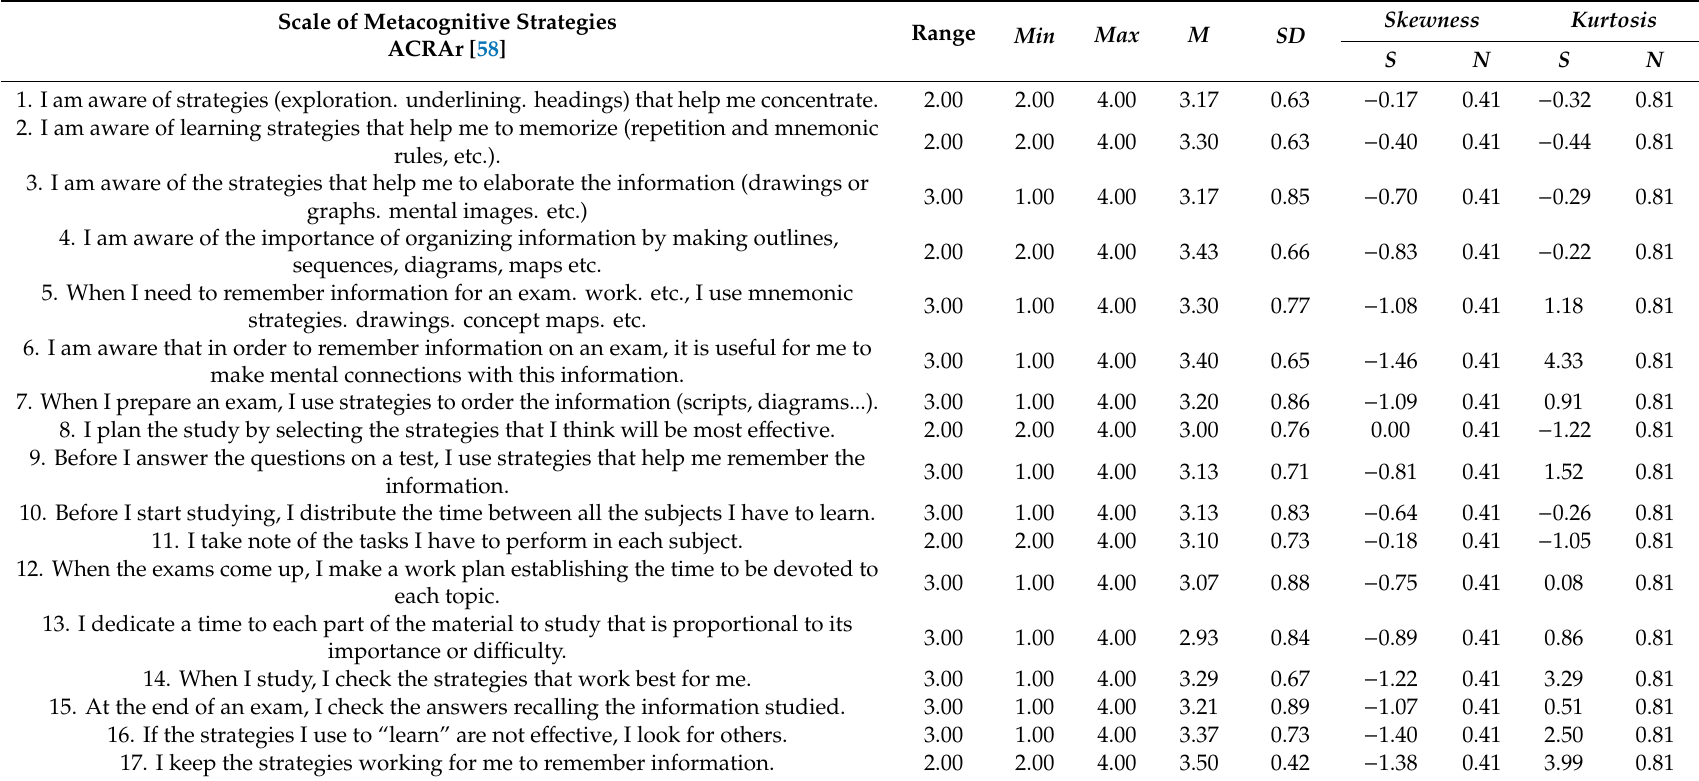
Table A2. Analysis of the asymmetry and kurtosis values of the distribution. Scale of Metacognitive Strategies ACRAr